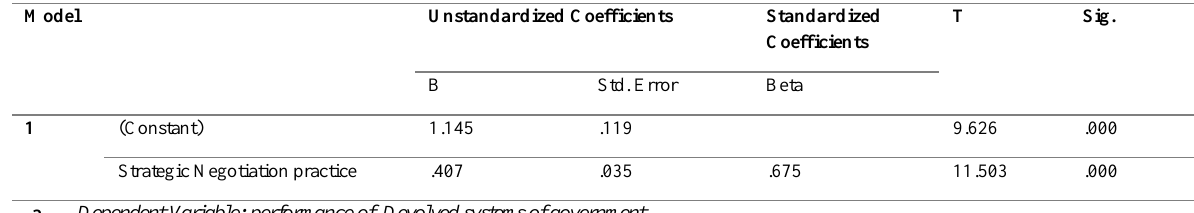
Table 4: Coefficients a of Strategic Negotiation